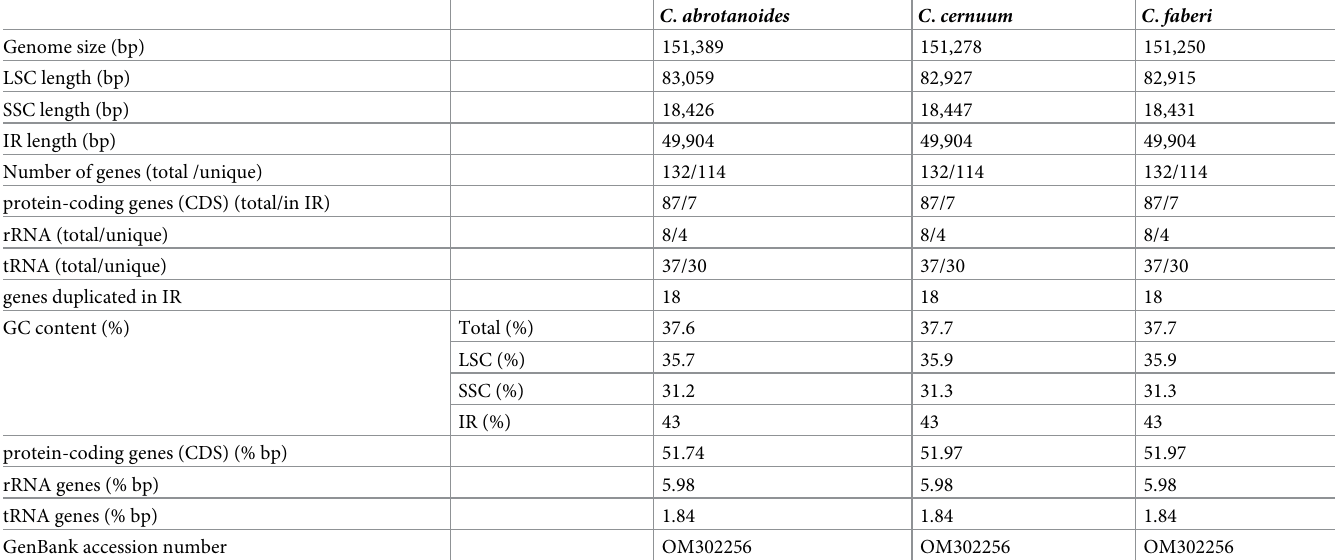
Table 1. Basic characteristics of the cp genomes of three Carpesium